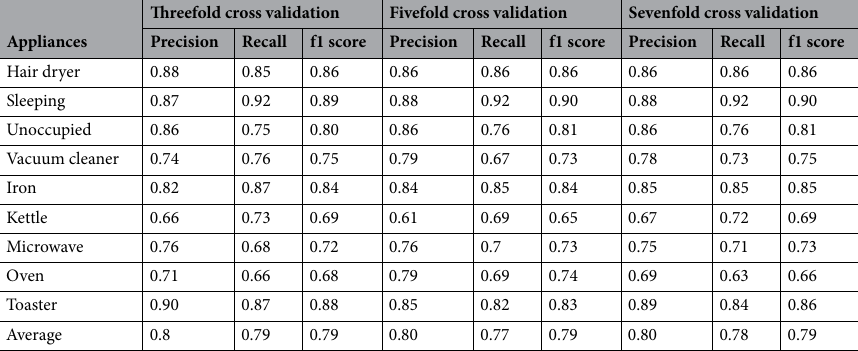
Table 5. Performance evaluation for case 1 with three, five, and sevenfold cross-validation.